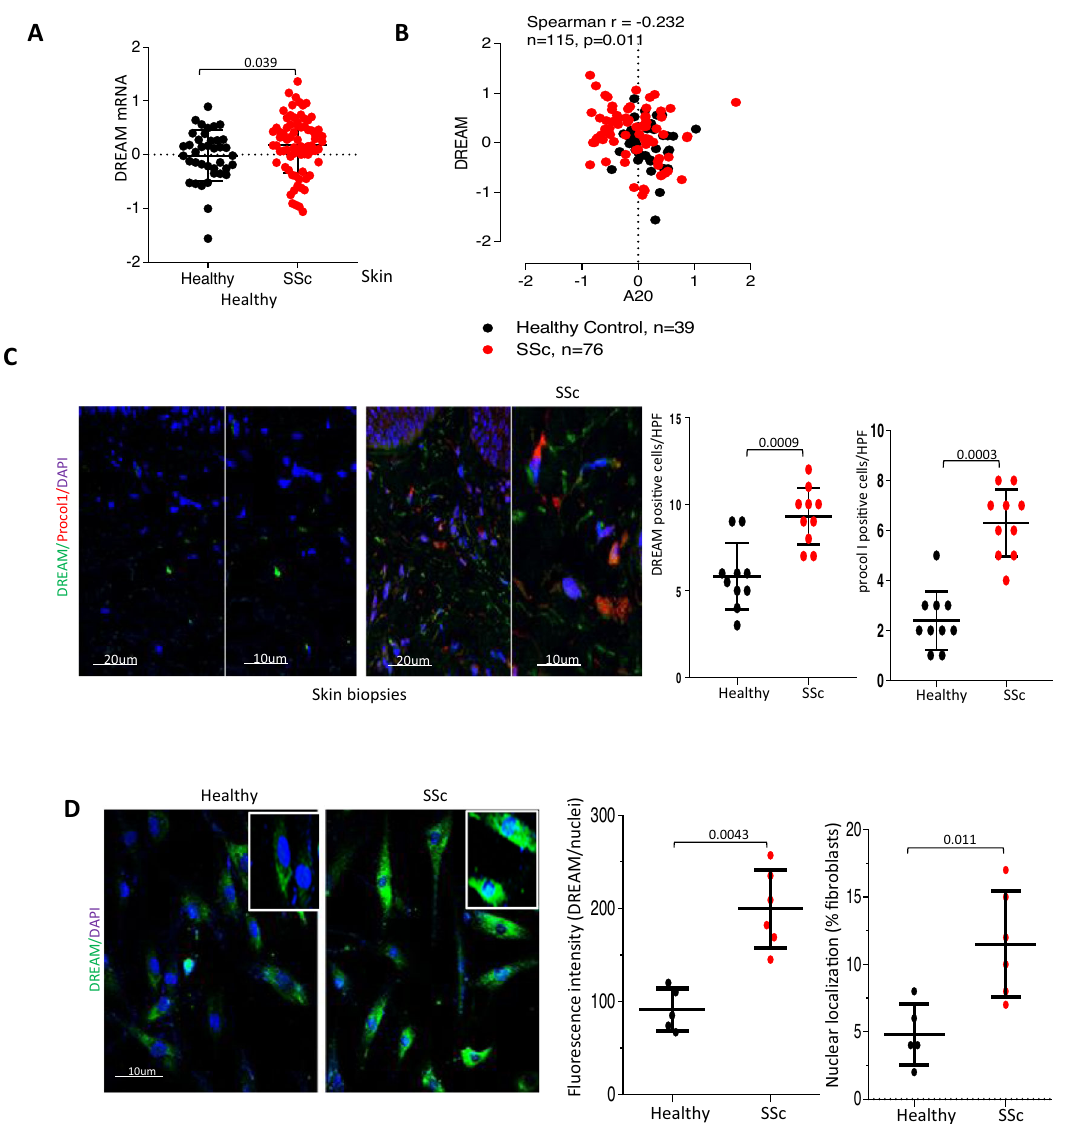
Fig. 5 | Dream is elevated in SSc biopsies, and negatively correlated with A20. A DREAM mRNA expression in SSc skin biopsy-derived microarray datasets (GSE59785, GSE45485, and GSE32413). Each dot represents a single subject (HC, n =39, SSc, n =76). Two-tailed Mann – Whitney U test. B Correlation of A20 and DREAM mRNA in each biopsy. Spearman ’ s correlation. C Immunolabeling of SSc ( n =10) and healthy control ( n =10) skin biopsies with antibodies to DREAM and procollagen 1. Left panels: representative immuno fl uorescence images. Bars=20 and 10 µ m. Right panel: number of immunopositive cells determined from 4 hpf/